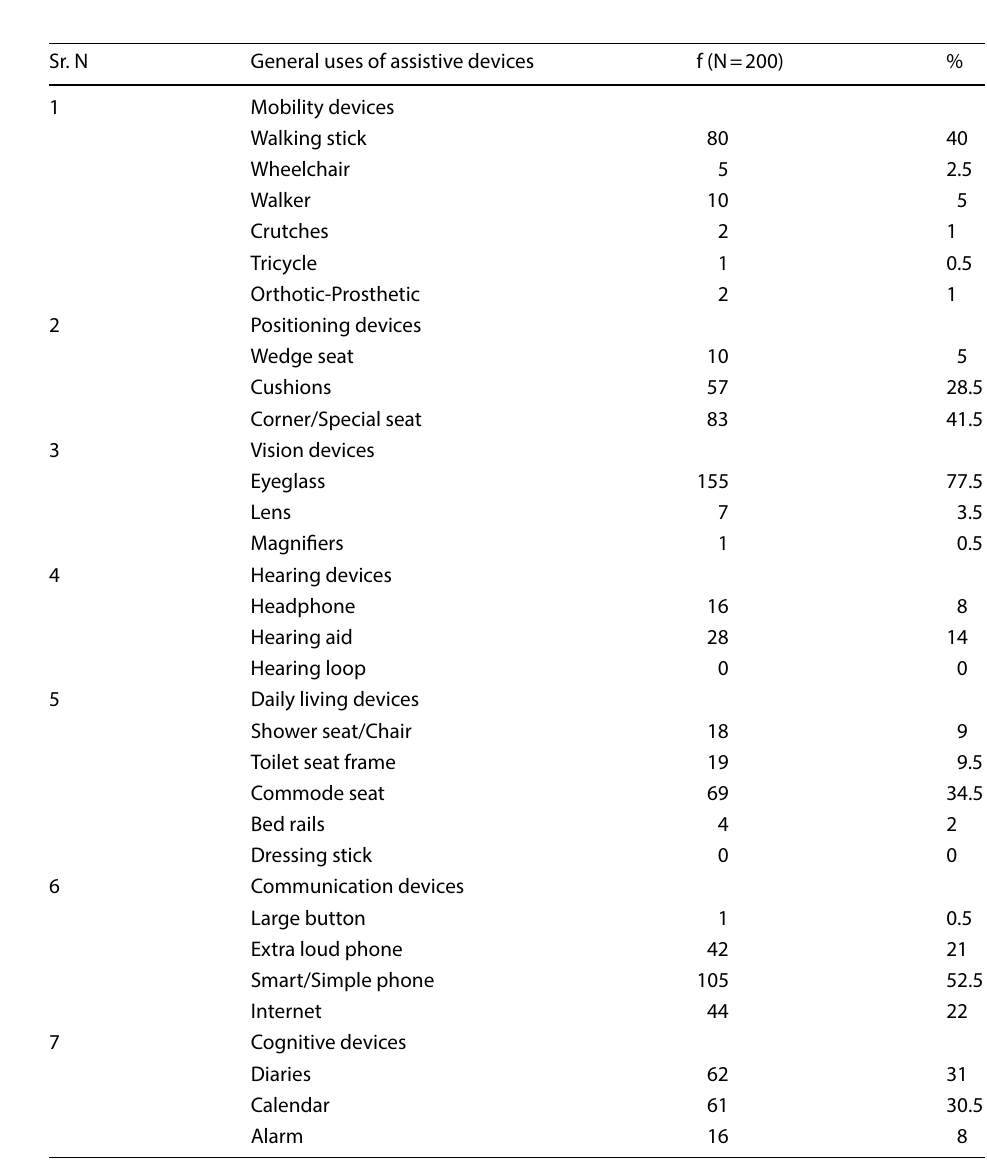
M mean, S.D. standard deviation, NS